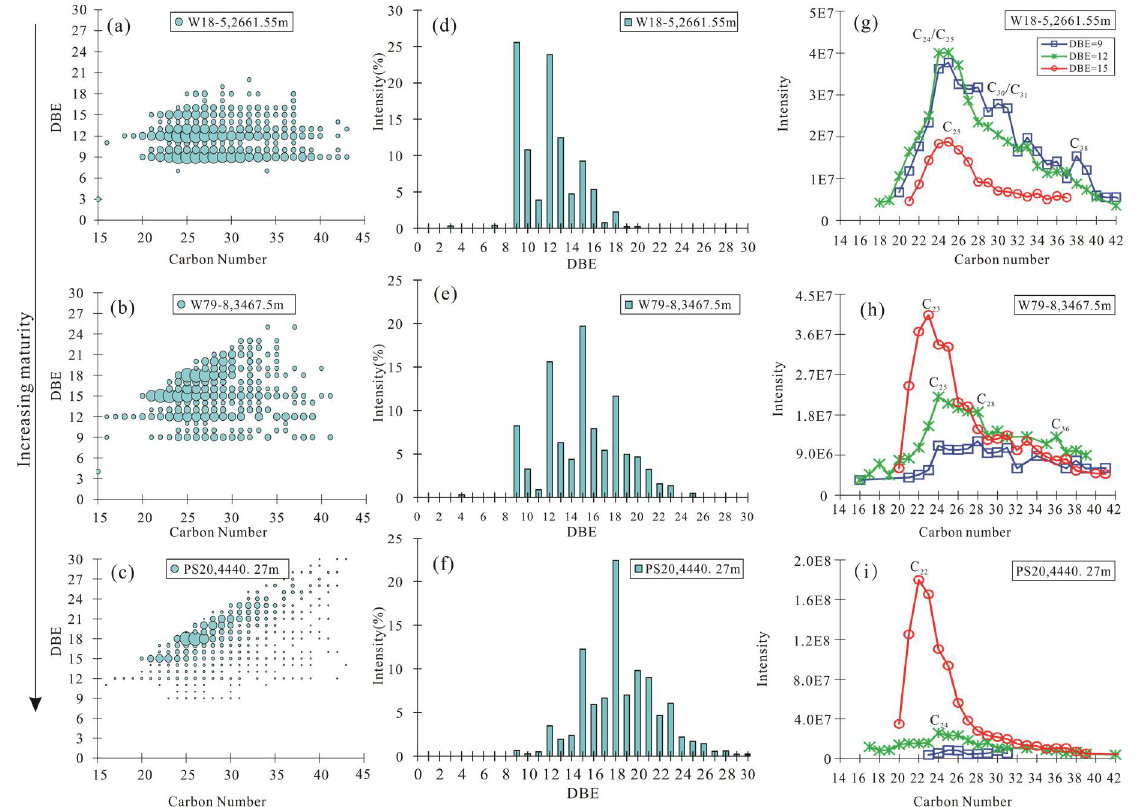
Figure 7. The relationship between the carbon number and DBE and its intensity ( a – c ), relative abundance of different DBEs ( d – f ), and carbon number and abundance distribution of DBE = 9, 12, and 15 ( g – i ) of N 1 type with different maturities that was detected by negative ion ESI FT-ICR